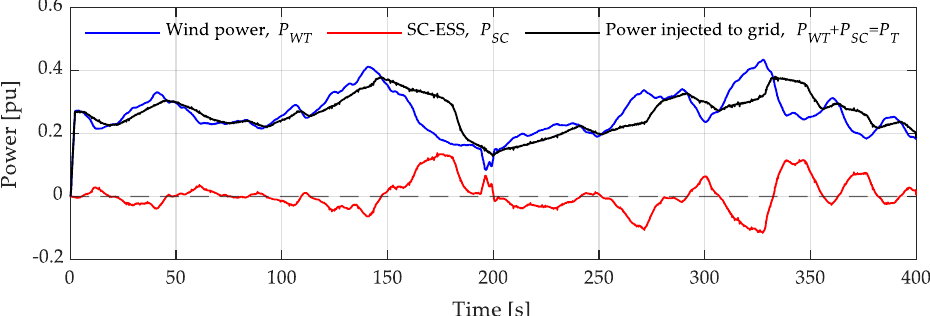
Figure 17. Experimental results, original injected wind power (blue), power delivered by SC–ESS (red), combined wind-supercapacitors effect with the smoothing algorithm (black).